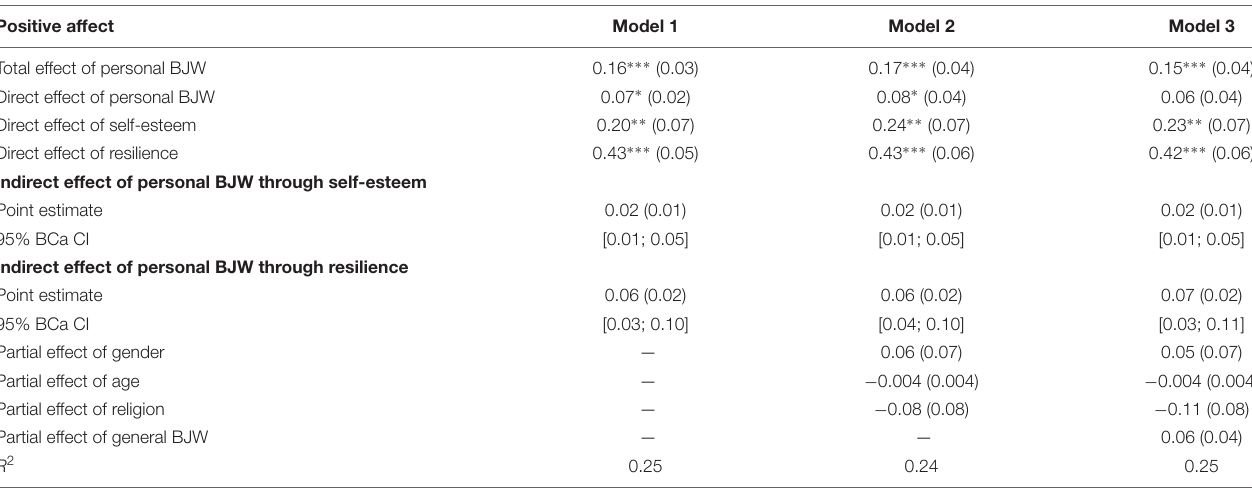
TABLE 3 | Results from bootstrap mediation analyses for positive affect ( N =